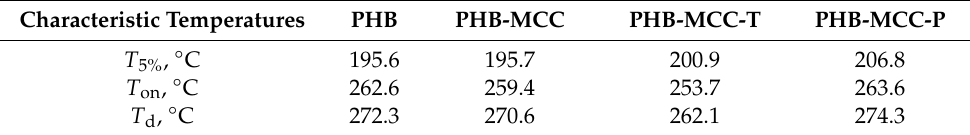
Table 3. results for PHB composites with different treated MCC .